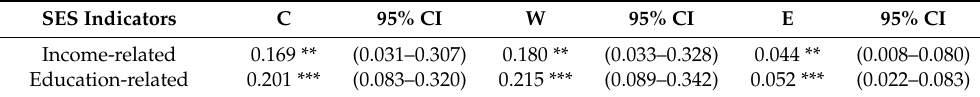
Table A1. Inequality indices in mammography screening (age 50–74, n = 1001).